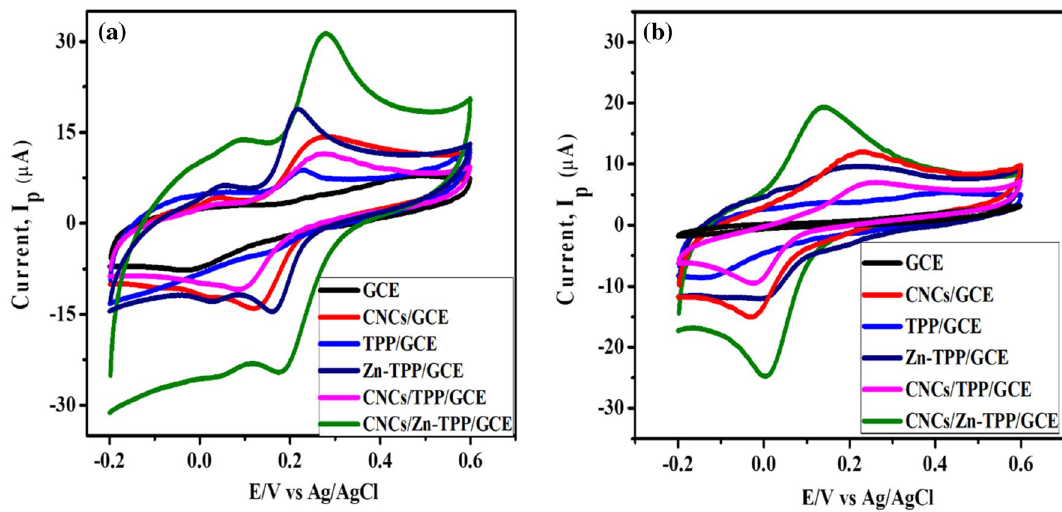
Figure 6. CV of GCE, CNCs/GCE, TPP/GCE, Zn-TPP/GCE, CNCs/TPP/GCE and CNCs/Zn-TPP/GCE in 0.1 M PBS (pH 7) containing ( a ) 500 µM catechol and ( b ) 500 µM